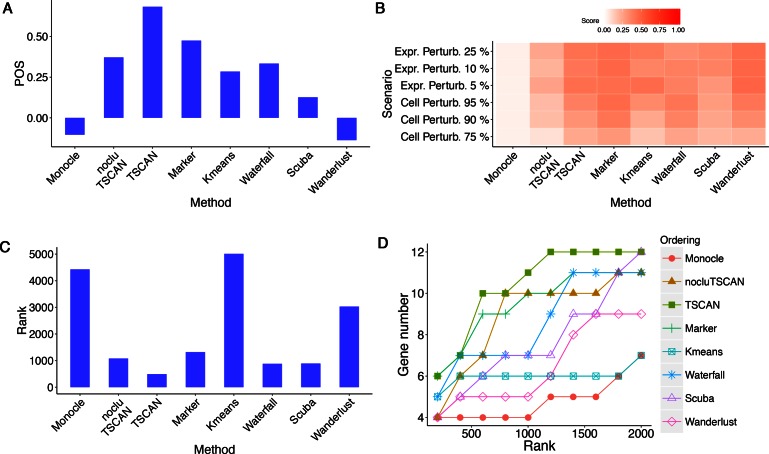
Evaluation results for different methods in HSMM data where pseudo-time was
constructed using all genes. (A) POS score. (B) Robustness
measured by the average similarity score from 100 independent perturbations.
(C) Mean rank of gold standard genes. (D) Number of
detected gold standard genes among top differential genes.